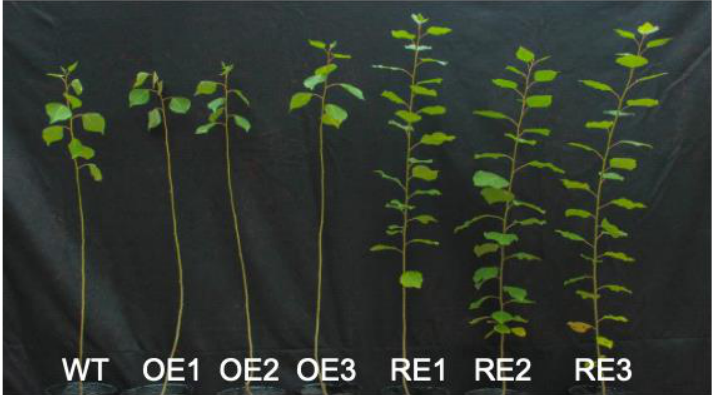
Figure 3. Phenotypic images among poplar transgenic and WT lines at day 15 under NaHCO 3 stress treatment. Table 1. The difference of plant height growth among OE, RE and WT lines under NaHCO 3 stress treatment.